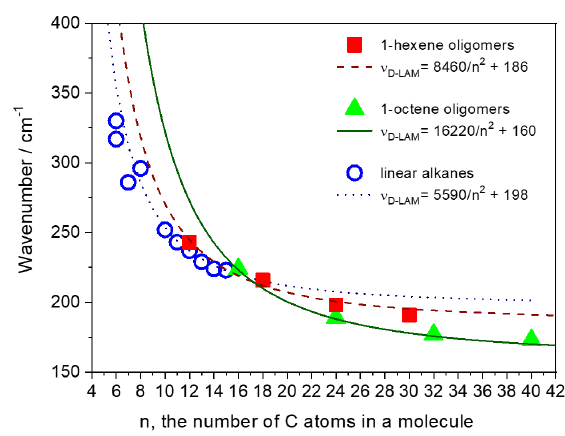
Figure 4. Peak position of the D-LAM band versus the total number ( n ) of C atoms for liquid linear alkanes and the hydrogenated 1-hexene and 1-octene oligomers. Symbols are the observed D-LAM wavenumbers: 1-hexene ( ■ ) and 1-octene ( ▲ ) oligomers, linear alkanes ( ○ ), curves (solid, dash and dot) are the fitting functions ν D-LAM (cm − 1 ) = A/n 2 + b (see text). The measurement errors of the peak positions are less than 3 cm − 1 .